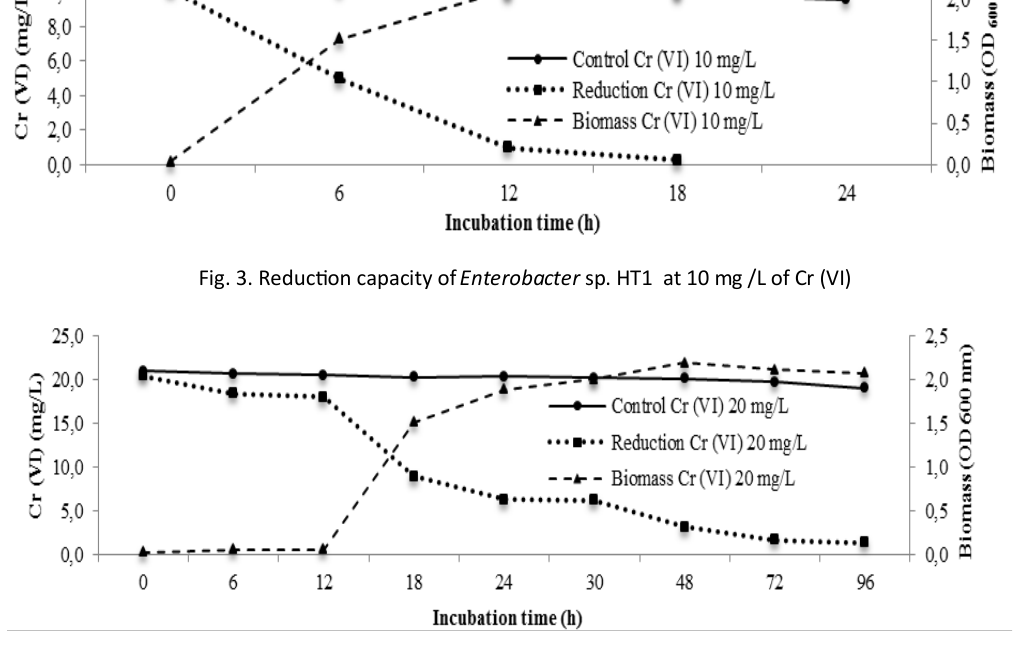
Fig. 4. Reduction capacity of Enterobacter sp. HT1 at 20 mg/L of Cr (VI)